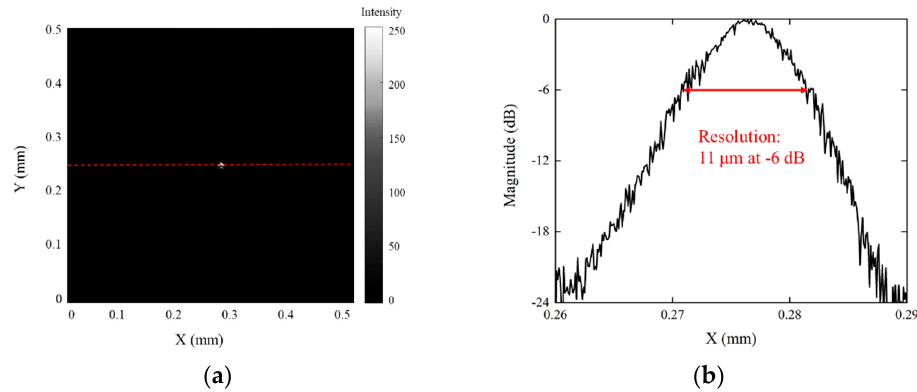
Figure 7. ( a ) An ultrasonic image of the 10 μ m tungsten wire. ( b ) The lateral resolution of the UHF ultrasonic transducer.